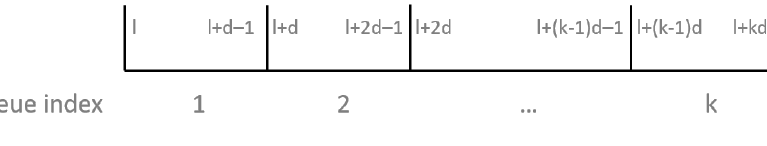
Figure 2. Time-aware